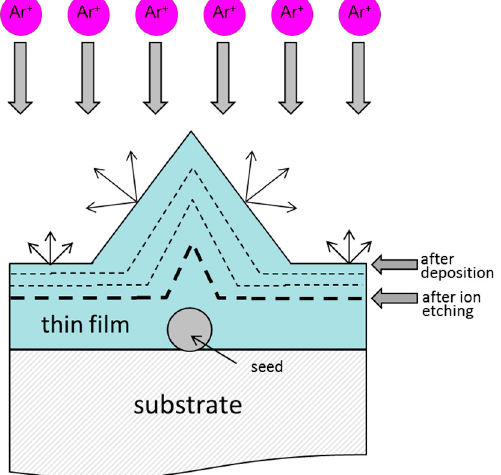
Figure 27. Illustration of the ion etching process applied for planarization of the coating surface.